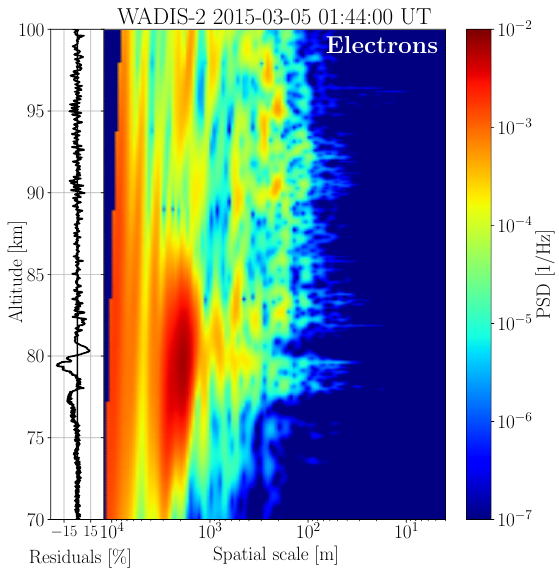
Figure 9. Left panel: measured electron density fluctuations (resid- uals) of the forward CONE EP from the upleg part of the WADIS-2 flight. Right panel: wavelet power spectrum of the residuals. The wavelet transformation was performed using a 12th-order Morlet wavelet.